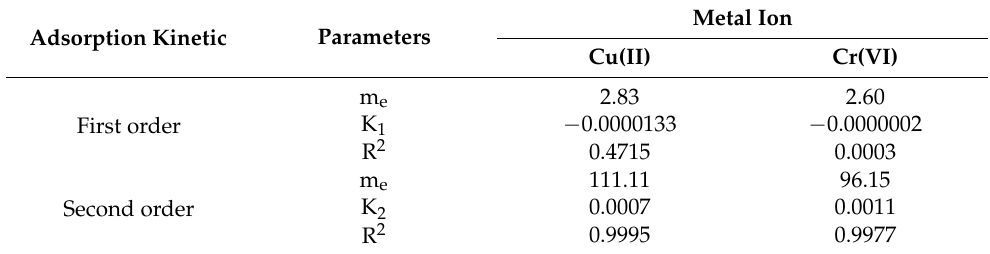
Table 2. Kinetic model parameters for Cu(II) and Cr(VI) adsorption onto C-ZLCH.